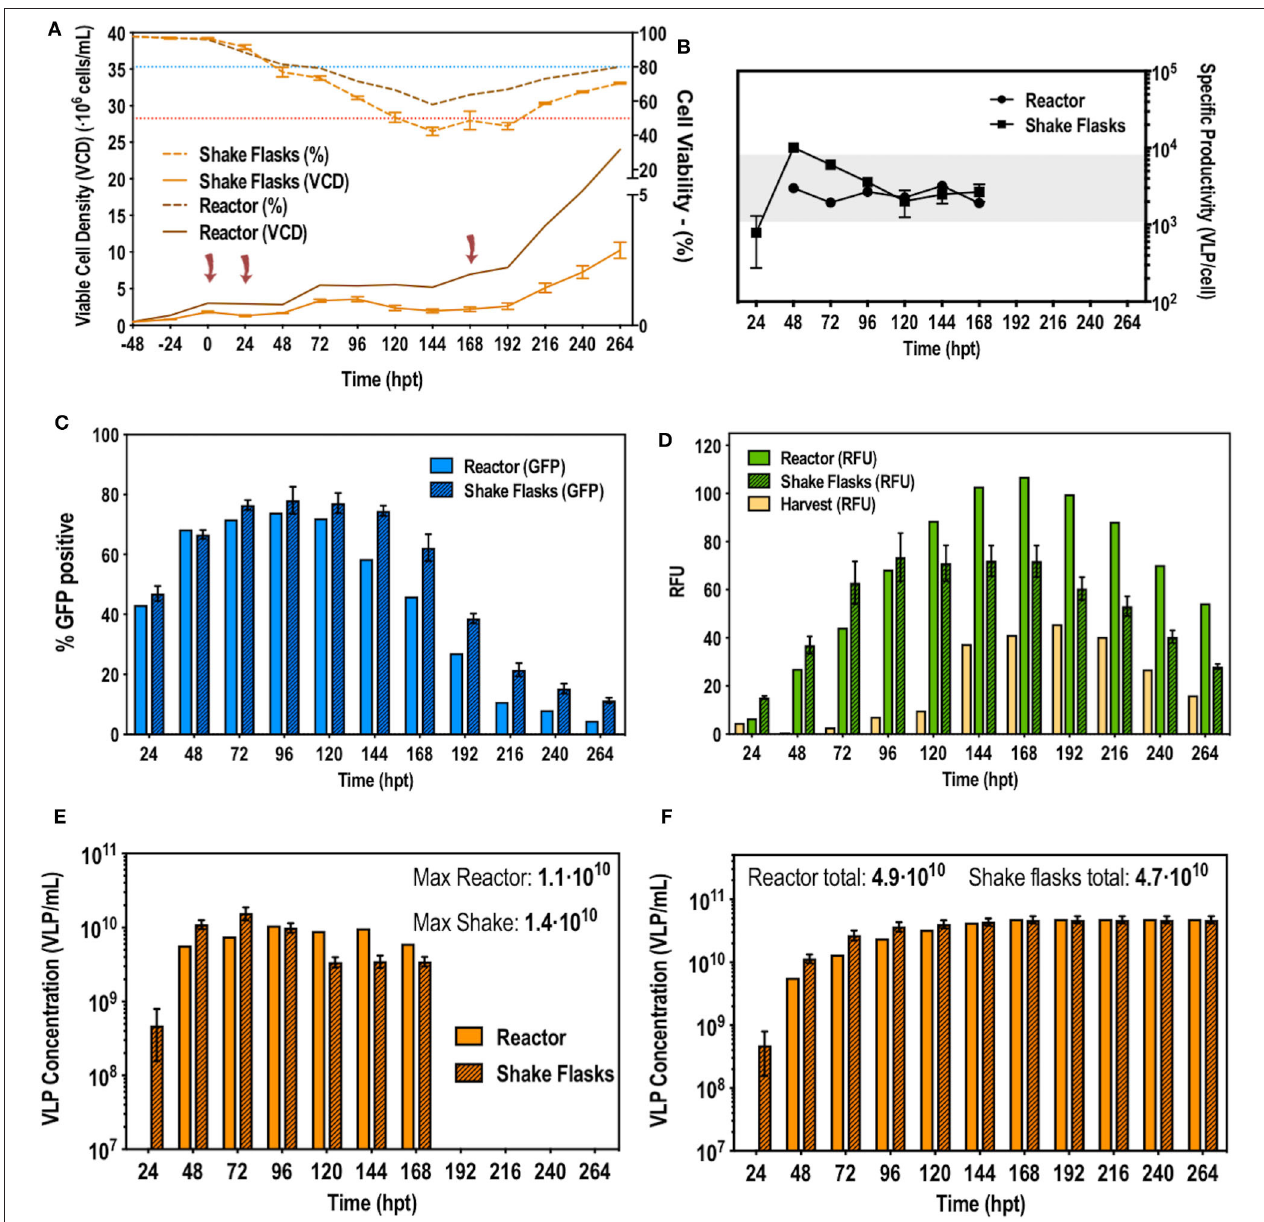
FIGURE 4 | Second retransfection at 168 hpt in bioreactor. (A) Viable cell density and cell viability graphs along the studied time course. The blue and red dotted line indicate 80 and 50% of cell viability, respectively. Cells were transfected at time point 0, 24, and 168h post-transfection (hpt) noted by red arrows. (B) VLP specific productivity rate along the studied time course. (C) Flow cytometry analysis of the transfection percentage (showed in GFP positive percentage of cells) along the time course. (D) Measurements of f luorescence in relative fluorescent units (RFUs) from the reactor, the harvest and the shake flasks. (E) Total VLP concentration produced per day (F) Total cumulative VLP